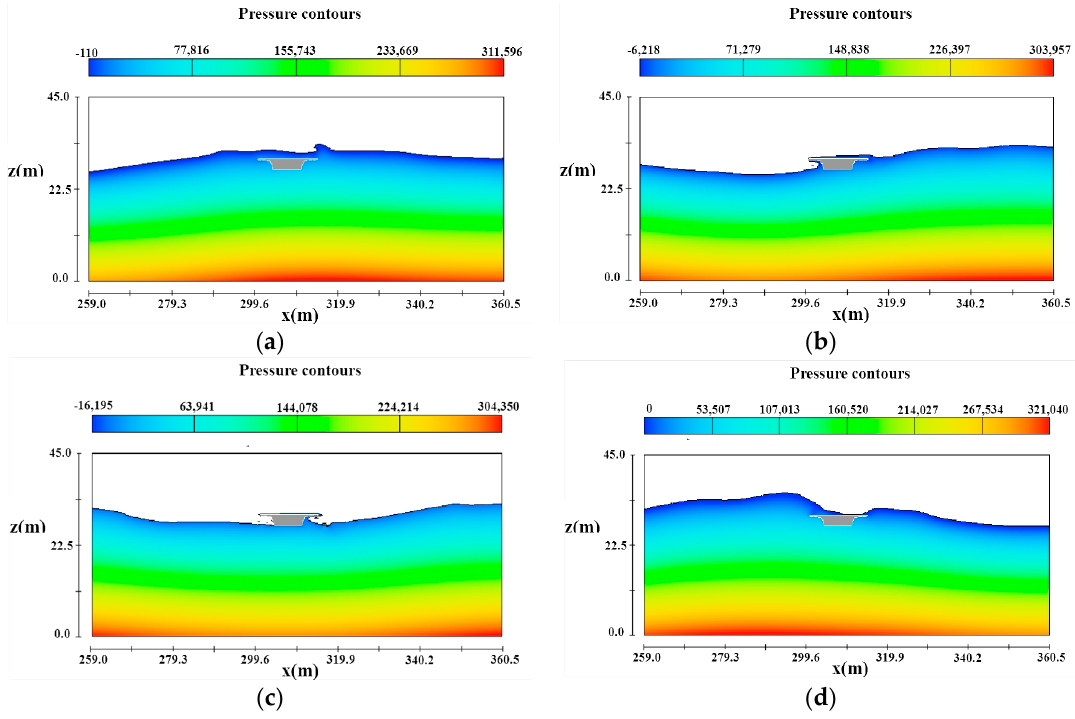
Figure 9. Variations of wave pressure around the box girder in a typical wave period. ( a ) t = t 0 ; ( b ) t = t 0 + T /4; ( c ) t = t 0 + T /2; ( d ) t = t 0 + 3 T /4.